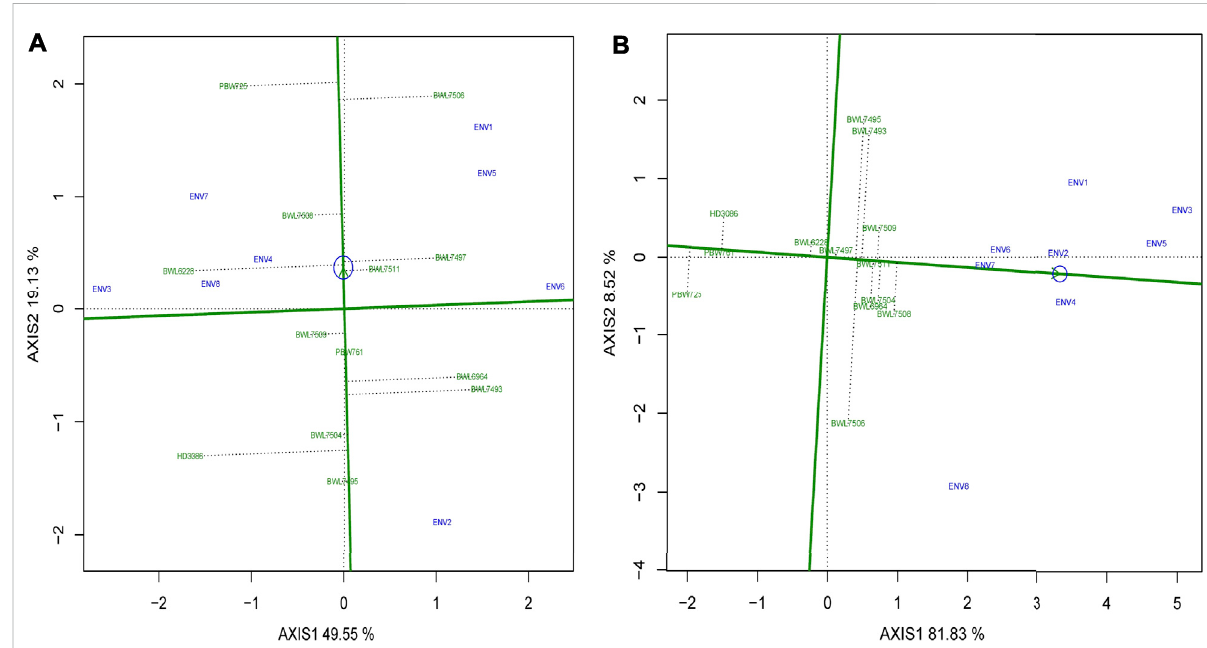
FIGURE 5 The “ mean versus stability ” model describing the interaction effect of 13 bread wheat genotypes evaluated across four locations (Ludhiana, Ballowal,Patiala,andBathinda)ofPunjabintwoconsecutiveyears(2019 – 20,and2020 – 21)for (A) yield(kg/plot)and (B) GPC(%).(ENV1,andENV5= Ludhiana; ENV2, and ENV6 = Ballowal; ENV3, and ENV7 = Patiala; ENV4, and ENV8 =